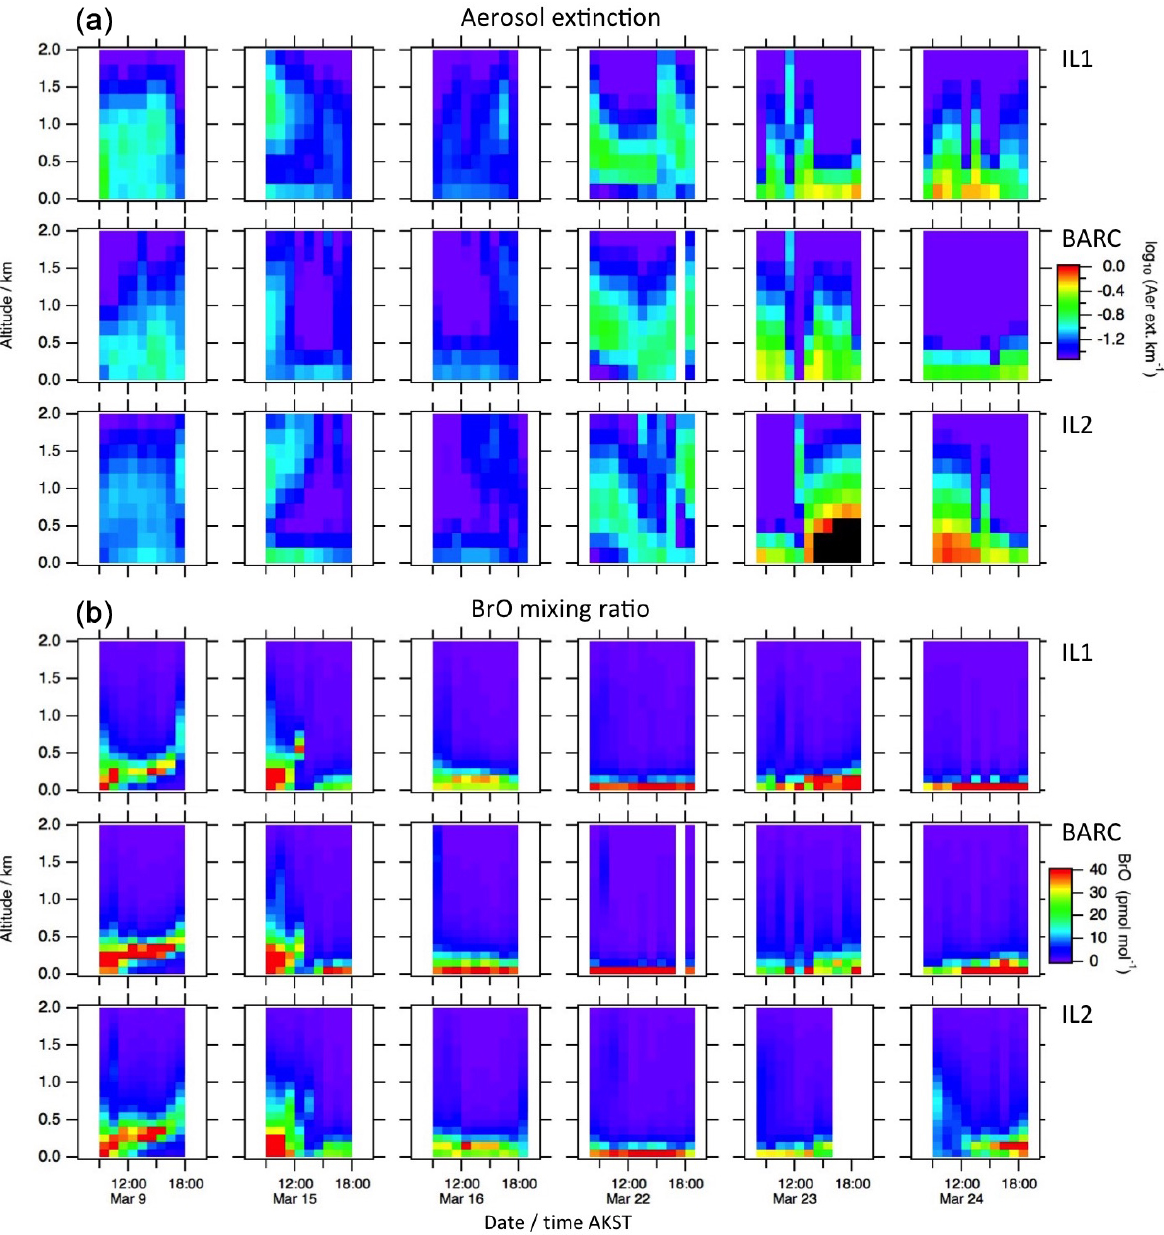
Figure 7. Altitude–time profiles of aerosol particle extinction (a) and BrO mixing ratio (b) on selected days during BROMEX in 2012. Ticks on the time axis occur every 3h. Black pixels indicate extinction above 1km − 1 , which may be too optically thick to be reliably calculated via the optimal-estimation analysis and probably make higher-altitude measurements at that time unreliable as well. BrO mixing ratios above 40pmolmol − 1 are shown as black and are most likely artifacts of the limited vertical resolution of the optimal-estimation analysis. White periods indicate missing data by lack of sun, instrumental problems, or low visibility (e.g., afternoon of 23 March at IL2 due to the lead opening